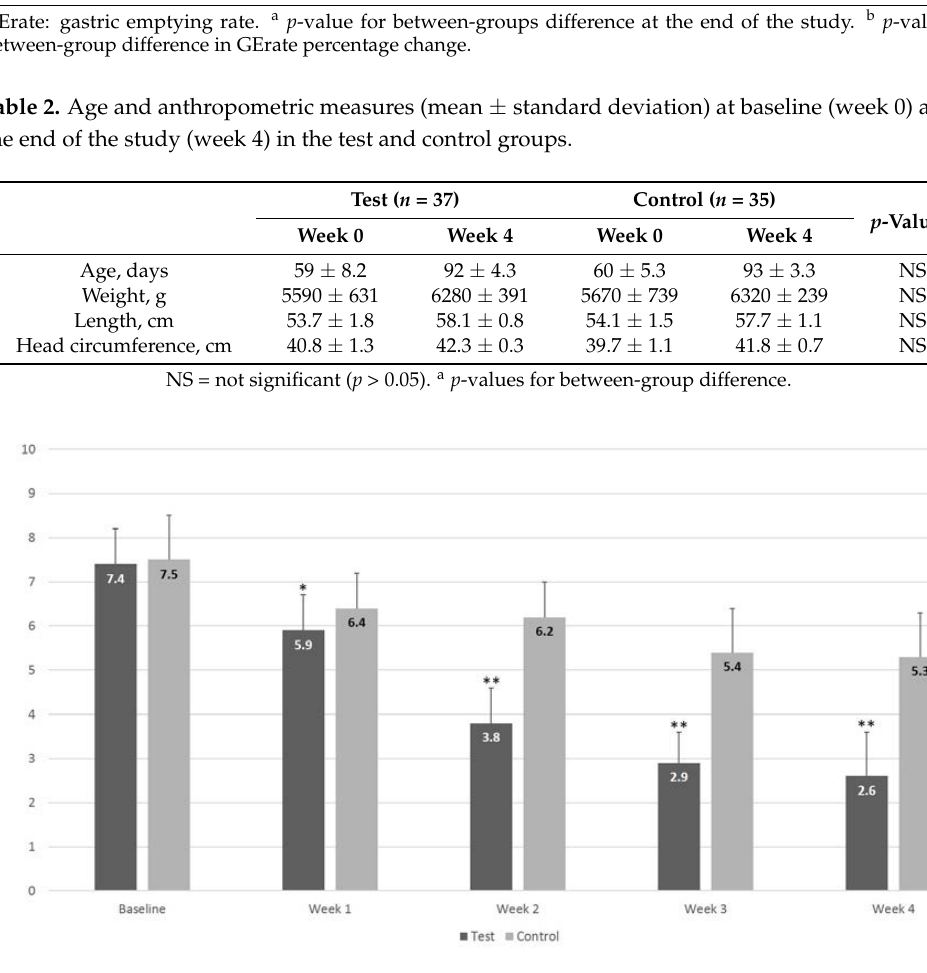
Table 1. Gastric emptying parameters, expressed as median (5th and 95th percentile) at baseline (week 0) and at the end of the study (week 4) in the test and control groups.